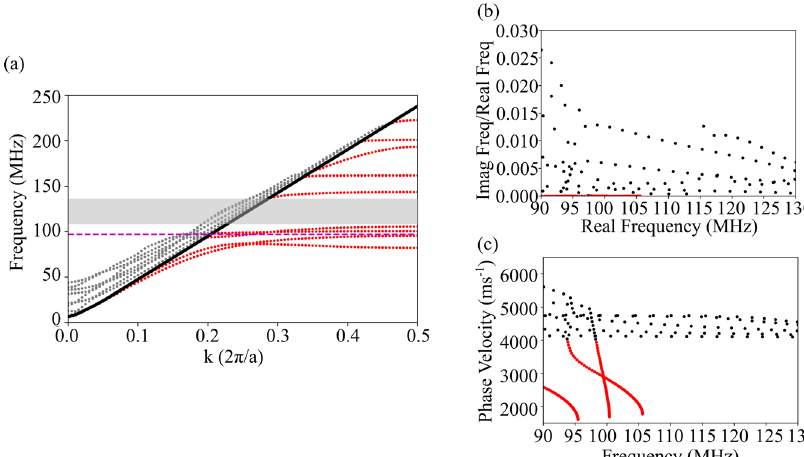
Fig. 1 Band diagram, attenuation and phase velocity data obtained from Eigenfrequency modelling. a Band diagram of the square annulus used in Array#1. The grey shaded region shows the largest bandgap region and the magenta dashed line is positioned at 97 MHz, i.e. the transducer resonance chosen for characterization. The black line represents the Rayleigh line. Array#1 has a unit cell length a = 8.4 µ m. Grey and red points represent modes above and below the Rayleigh line, respectively. b Imaginary frequency divided by real frequency showing attenuation of the system. Black and red points represent modes above and below the Rayleigh line, respectively. c Phase velocity of the system calculated from ( a ). Black and red points represent modes above and below the Rayleigh line, respectively. All plots show the fi rst 9 solutions representing the 9 lowest eigenfrequencies solved in the model for each value of k . See Supplementary Fig. 4 for data up to solution 12. Data obtained using COMSOL Multiphysics ® 38 .